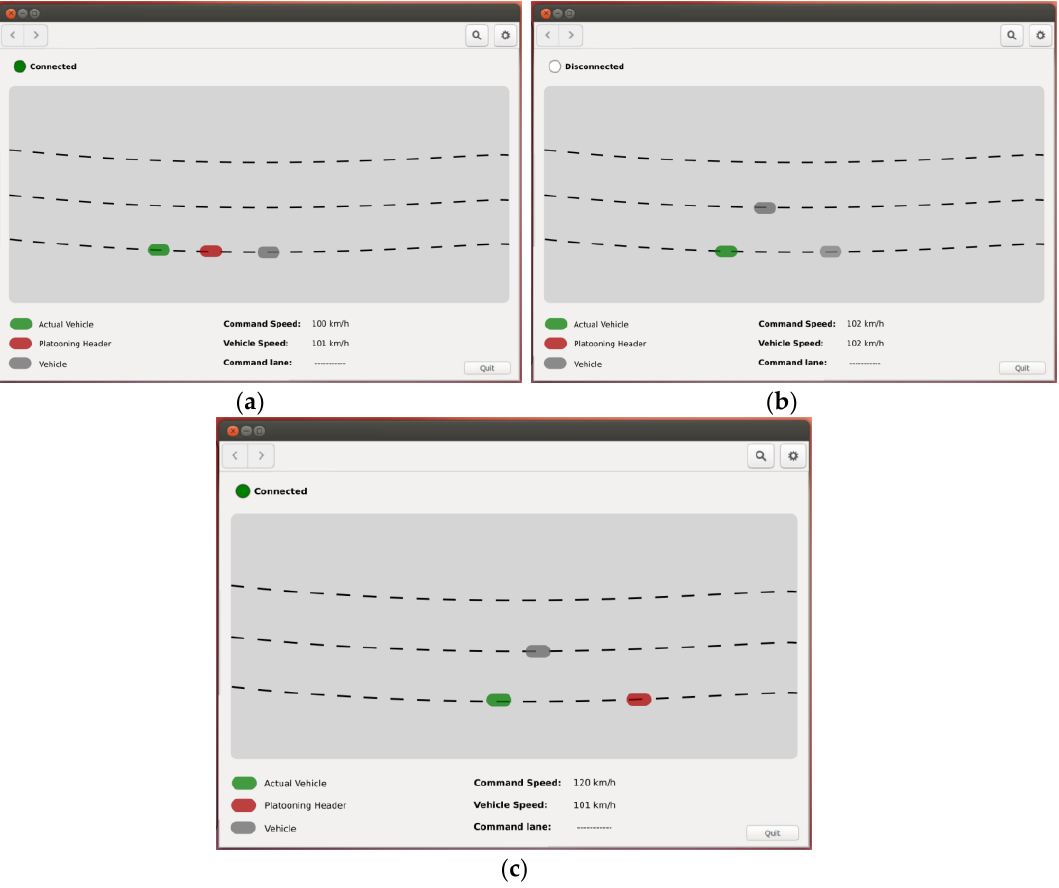
Figure 10. Cut-out maneuver: ( a ) Top left: Screenshot of a three-vehicle platoon; ( b ) Top right: Screenshot of the second vehicle’s lane change (cut-out); ( c ) Below: Screenshot of the net reconnection. Table 4. Results of the cut-out maneuver